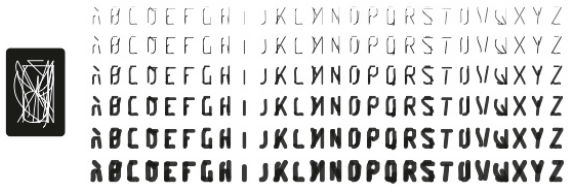
Figure 13: Stencil evolved and applied in experiment IV. The variation of the thickness of the stencil lines (left) generates a wide,continuousrangeoftypographicweightsthatprovidedifferent visual emphasis